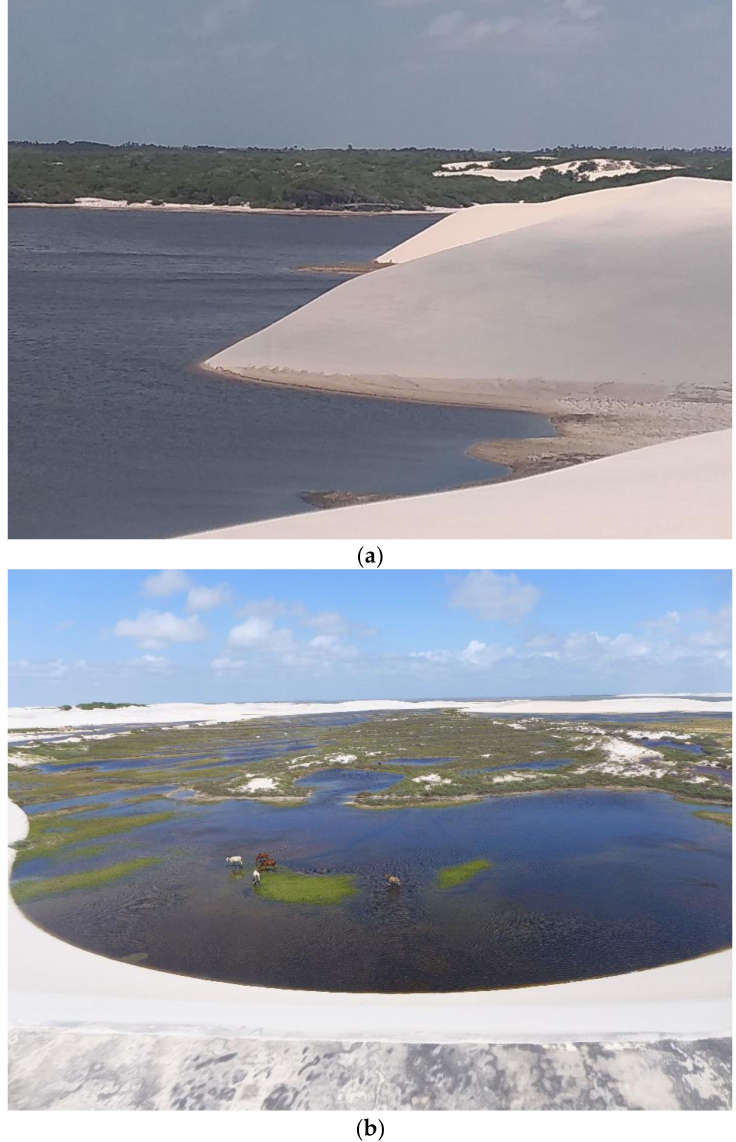
Figure 3. ( a ) Mobile dunes; ( b ) Animals grazing on the grasslands ( vargens